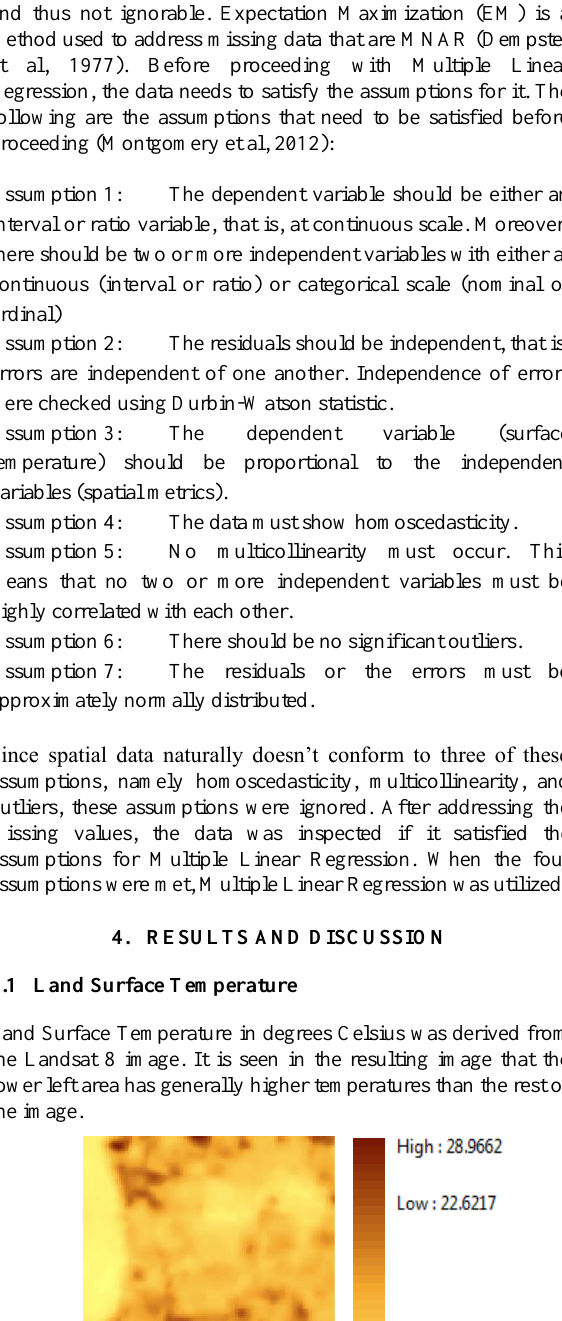
‘coefficient of variation’, respectively. Table 2. Class-level spatial metrics derived from FRAGSTATS